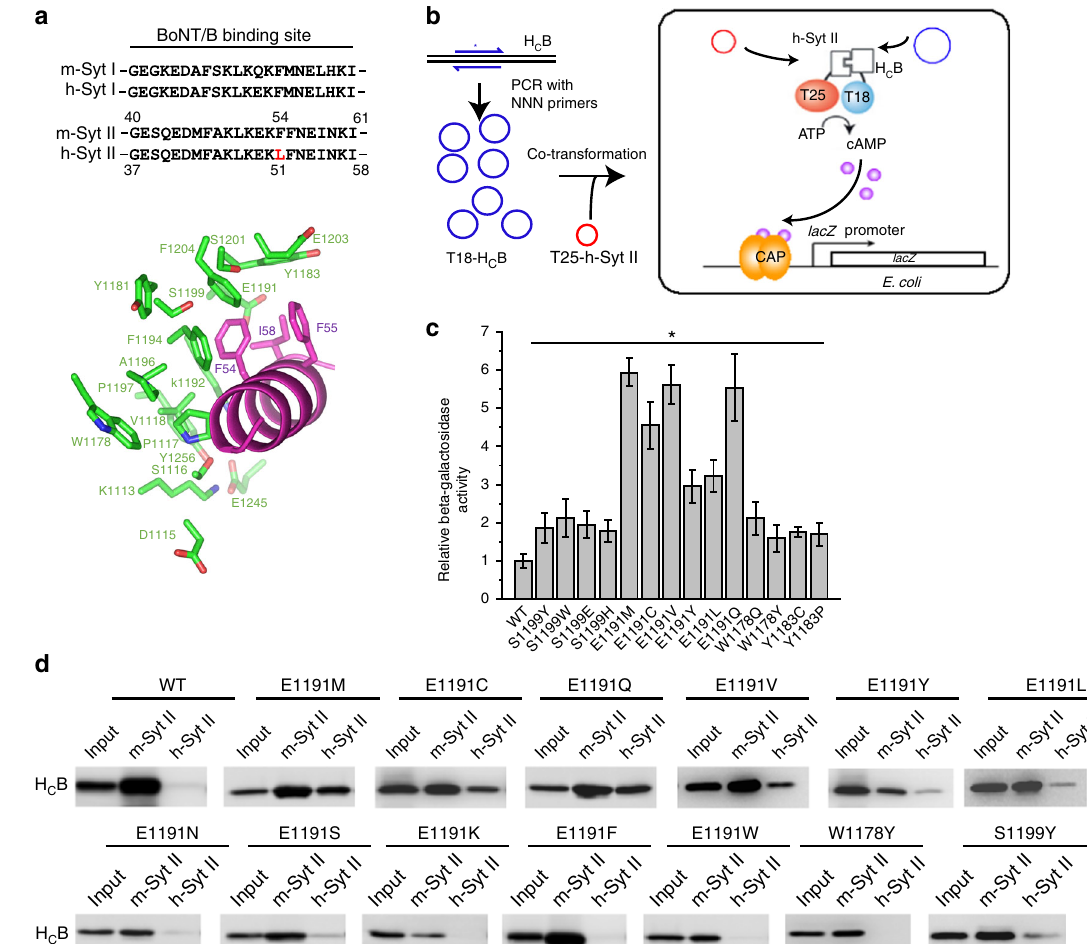
Fig. 1 BACTH screen identi fi es mutations that enhance BoNT/B binding to h-Syt II. a Sequence alignment of the BoNT/B-binding site in mouse Syt I (m-Syt I), h-Syt I, h-Syt II, and mouse Syt II (m-Syt II), and a close-up view of the interface between H C B and Syt II. Targeted residues in BoNT/B for mutagenesis studies are labeled in green . Syt II residues are marked in purple , with F54, F55, and I58 being highlighted. b A schematic illustration for construction of H C B mutant libraries and the BACTH assay. c H C B mutants identi fi ed in the BACTH assay were further analyzed by β -galactosidase activity assay, which re fl ects the levels of reconstituted adenylate cyclase (Student ’ s t -test, n = 6, * P < 0.05). Error bars represent SEM. d Point mutations at E1191, W1178, and S1199 were examined in pull-down assays, using immobilized m-Syt II (residues 1 – 87) or a mouse Syt II (1 – 87) containing F54L mutation that mimics h-Syt II sequence (designated as h-Syt II). Bound H C B variants were detected by immunoblot analysis detecting the HA-tag fused to H C